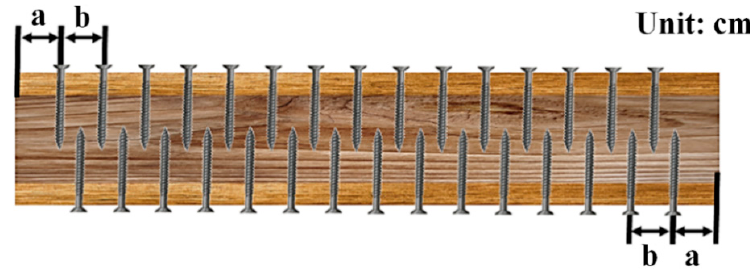
Figure 3. Self-tapping screw drive-in positions.